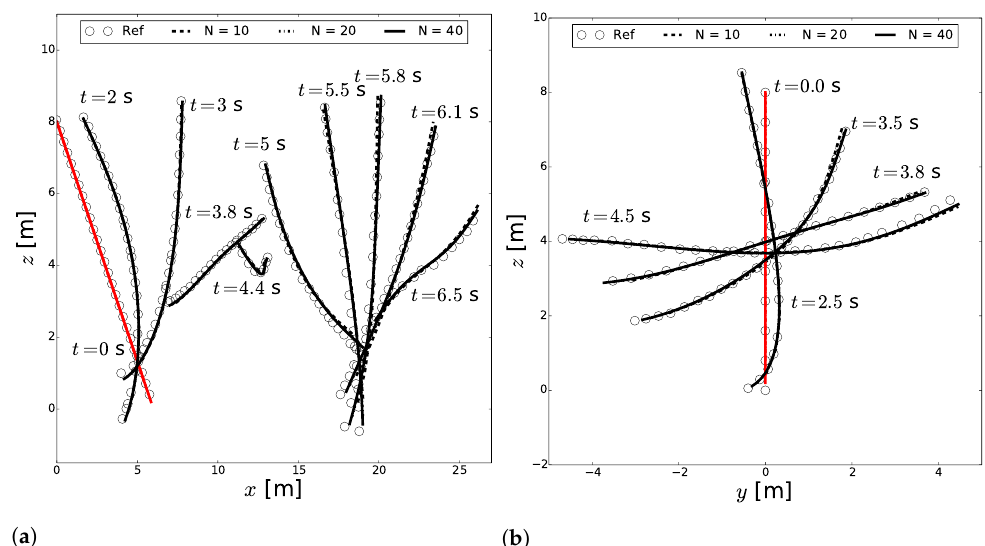
Figure 7. Motion of the free-free flexible rod for the three-dimensional load case. The red lines show the initial position of the rod. The reference solution was taken from [48]. ( a ) Motion in the x-z plane. ( b ) Motion in the y-z plane.